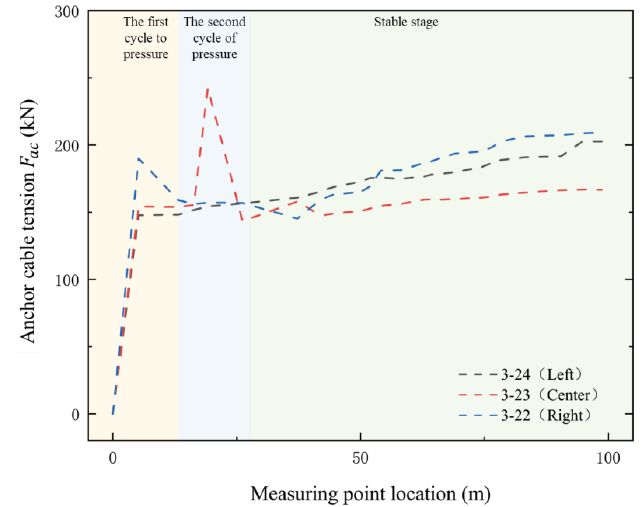
Figure 18. Tension force distribution on the anchor cable.